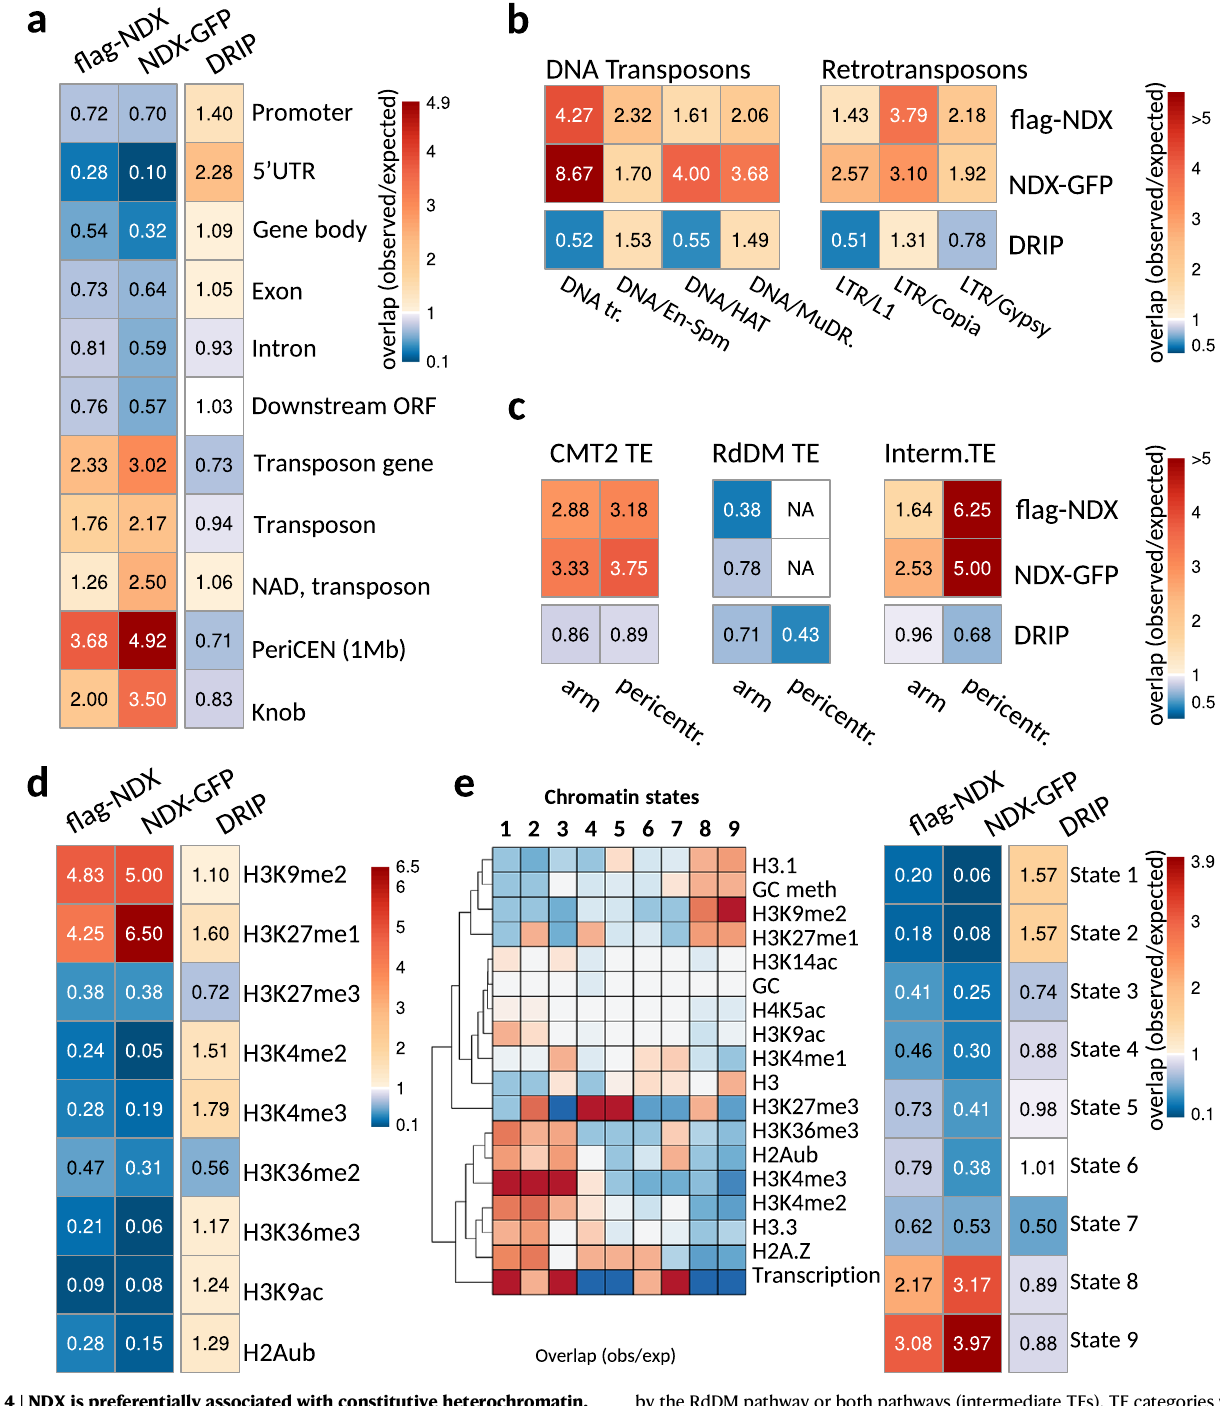
by the RdDM pathway or both pathways (intermediate TEs). TE categories were further classi fi ed as pericentromeric and arm-associated. NA: lack of statistical powerduetoverylowpeakcountintheindicatedcategory. d Thesameannotation as above for histone modi fi cations, and e chromatin states. The nine chromatin states were de fi ned by the combinatorial pattern of epigenetic modi fi cations and transcription 50